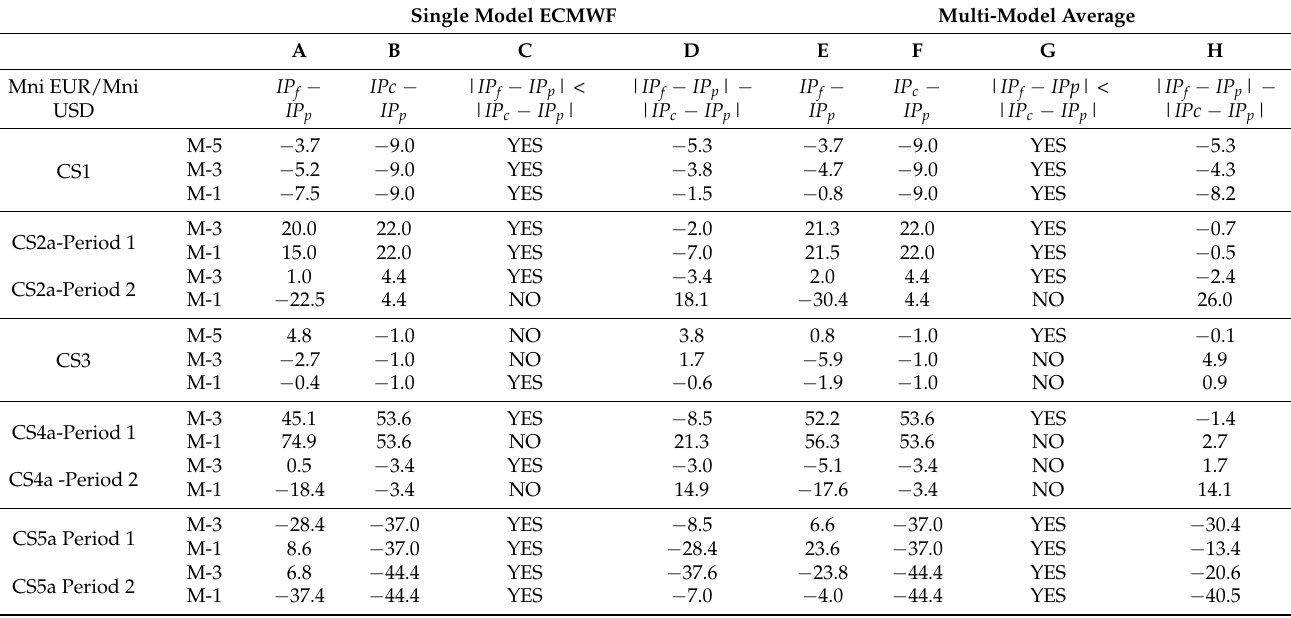
Table 2. Summary of results for the quantification of value-add in the Enel evaluation process for case studies CS1 to CS5a. Results are shown for different lead times (five (M-5) months, three (M-3) months, and one (M-1) month) and for a single model (ECMWF—columns A–D) and a multi-model average (Columns E–H). Indicators of Performance (IP) expressed in millions of Euros (millions of US dollars for CS5): IPf = seasonal forecast IP (test); IPp = actual IP (perfect forecast using actual data); IPc = climatology IP (control). Columns C and G show: YES—Equation (2) was fulfilled; NO—Equation (2) was not fulfilled. Columns D and H show the differences between the forecast